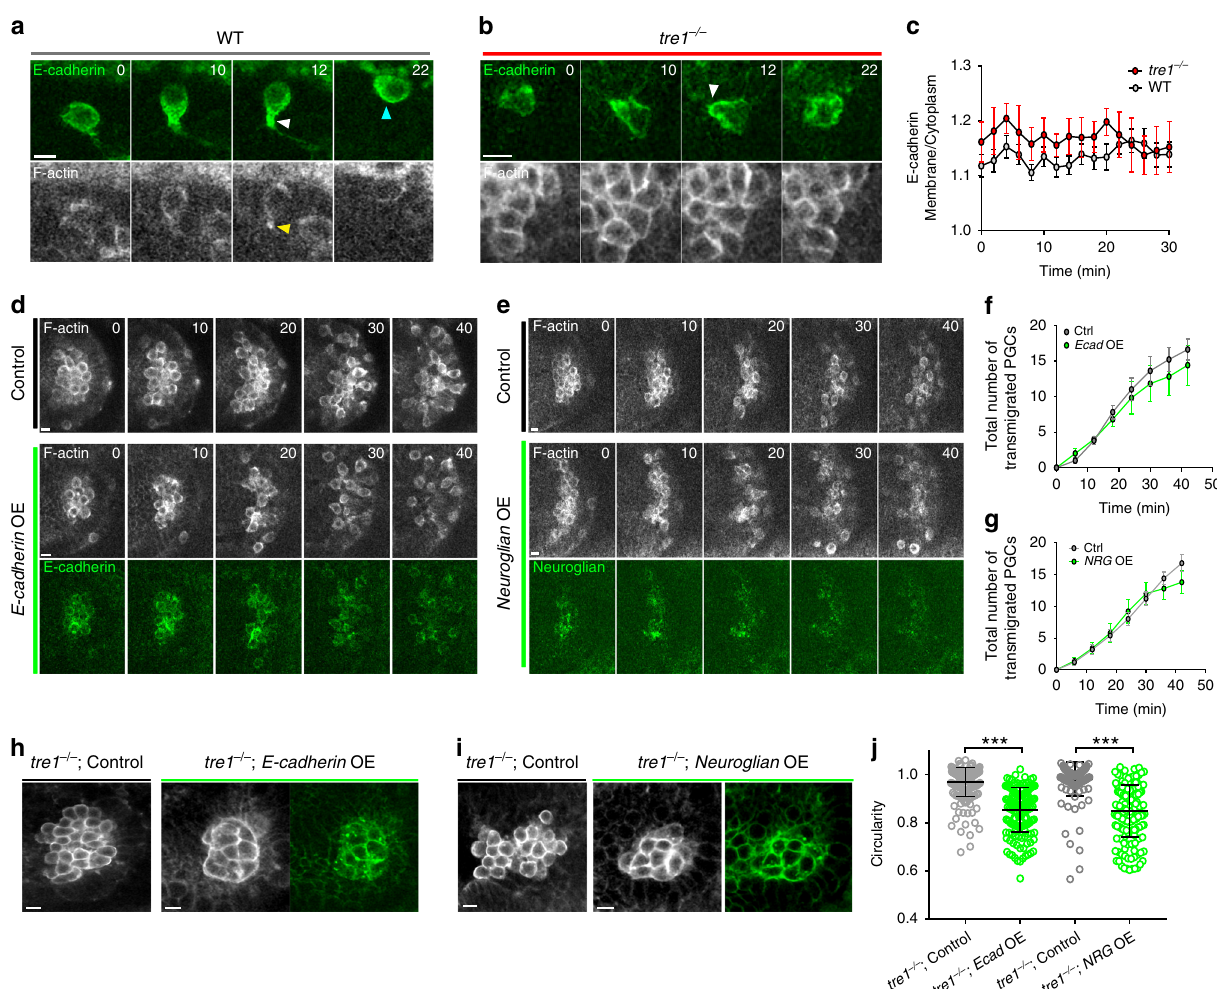
Fig. 6 PGC disperse without altering E-cadherin levels and can overcome increased adhesion. Two-photon timelapse imaging of representative transplanted WT ( a ) or tre1 − / − ( b ) PGCs expressing E-cadherin-3xGFP and lifeact-tdTomato within lifeact-tdTomato expressing WT ( a ) or tre1 − / − ( b ) embryos. White arrow marks region of E-cadherin enrichment and yellow arrow marks an F-actin focus. Cyan arrow marks posterior where E-cadherin remains enriched after separation is complete. Representative images are from n = 7 embryos in ( a ) and n = 5 embryos in ( b , c ) Quanti fi cation of E-cadherin membrane/cytoplasm ratio in transplanted WT ( n = 16 PGCs from 7 embryos) and tre1 − / − ( n = 9 PGCs from 5 embryos). Error bars are SEM. Two-photon timelapse imaging of a representative control (top panels), E-cadherinmClover2 ( d ) overexpressing (bottom panel), or Neuroglian-mClover2 ( e ) overexpressing (bottom panel) PGC cluster for 40 min post endoderm EMT. Representative images in ( d ) and ( e ) are from n = 5 embryos in both control and experiment. f – g Quanti fi cation of the total number of PGCs which have transmigrated in control ( n = 5 embryos) vs. E-cadherin-mClover2 overexpressing ( n = 5 embryos) ( f ) or control ( n = 5 embryos) vs. Neuroglian-mClover2 overexpressing ( n = 5 embryos) ( g ) for 40 min after endoderm EMT. Error bars are SEM. Representative Z slice from tre1 − / − control (left), tre1 − / − Ecadherin mClover2 overexpressing ( h ), or tre1 − / − Neuroglian mClover2 overexpressing ( i ) PGC cluster. Representative images in ( h ) are from n = 7 embryos in control and n = 8 embryos in experiment. Representative images in ( i ) are from n = 6 embryos in control and n = 9 embryos in experiment. j Quanti fi cation of the circularity of tre1 − / − PGCs under the following conditions-control ( n = 220 PGCs from 7 embryos) vs. Ecadherin-mClover2 overexpression ( n = 166 PGCs from 8 embryos) and control ( n = 155 PGCs from 6 embryos) vs. NeuroglianmClover2 overexpression ( n = 179 PGCs from 9 embryos). Data are presented as mean values + / − SD. Statistical comparisons are from a Mann – Whitney test with p < 0.0001 in both comparisons. *** p < 0.001. All times are in minutes. All scale bars, 10 μ m. Source data from ( c , f , g and j ) are provided as a Source Data fi